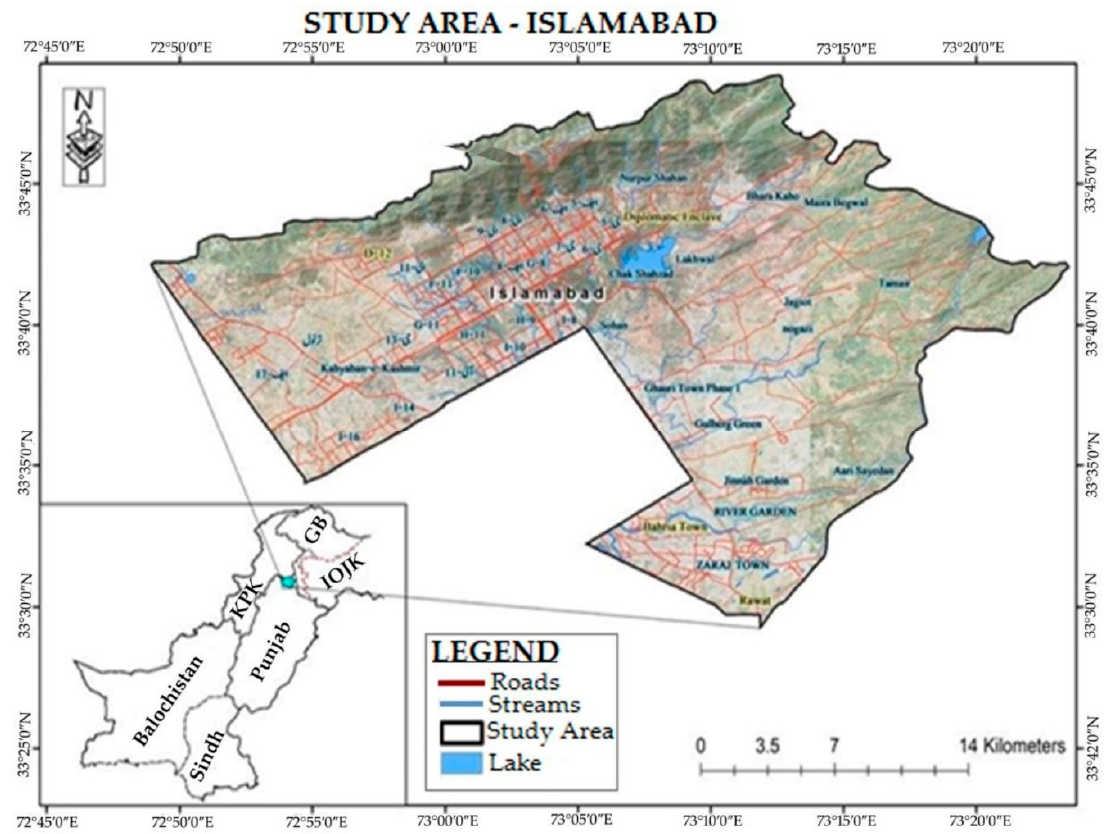
Figure 1. Location of the study area (Islamabad).